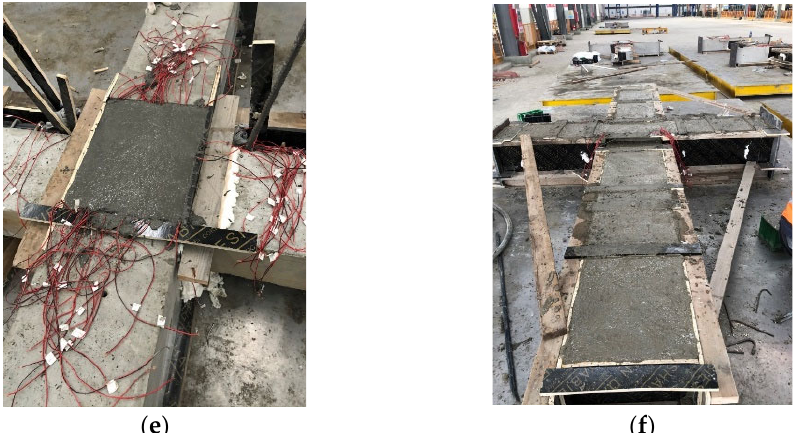
Figure 2. Fabrication process of specimens. ( a ) Pre-tensioning prestressed strands, ( b ) precast beams, ( c ) precast columns, ( d ) assembling of precast specimen, ( e ) UHPC in the joint zone, ( f ) cast-in-place specimen.